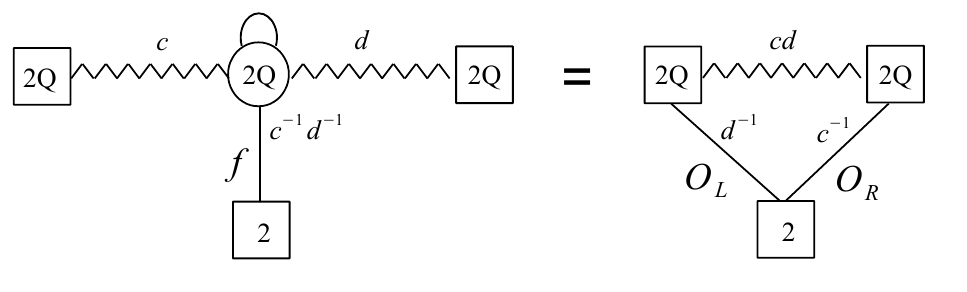
Figure 7: Schematic representation of the braid